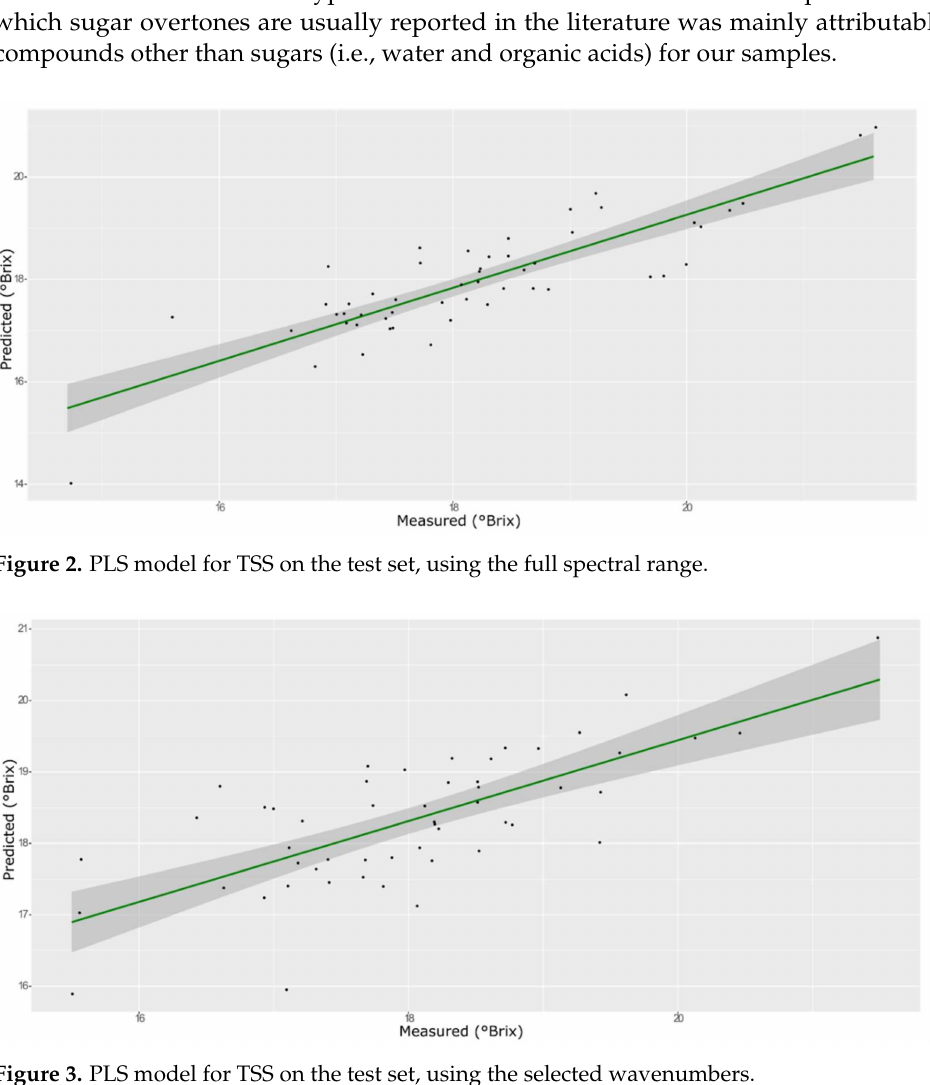
Figure 3. PLS model for TSS on the test set, using the selected wavenumbers. Table 1. Best performing models’ parameters for